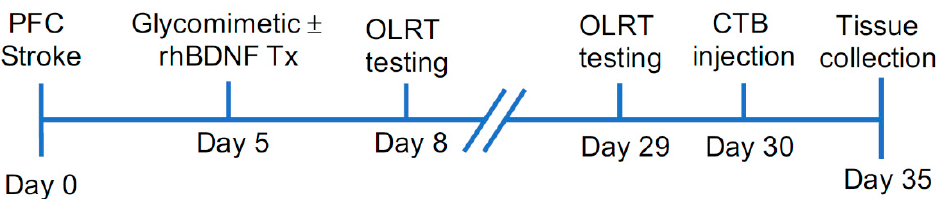
Figure 9. Experimental timeline illustrating the sequence of behavioural and surgical events following photothrombotic PFC stroke. Animals were pseudorandomised into treatment groups prior to receiving either PFC stroke or sham surgeries. After receiving either glycomimetic (compound A or G) or vehicle (saline) osmotic minipumps, with or without intracerebral injections of rhBDNF or vehicle (IgG-Fc), animals underwent the object location recognition task (OLRT) at one- and four- weeks post-stroke. Prior to tissue collections, animals received prelimbic injections of the retrograde cholera toxin subunit B (CTB) to allow for tracing of thalamocortical